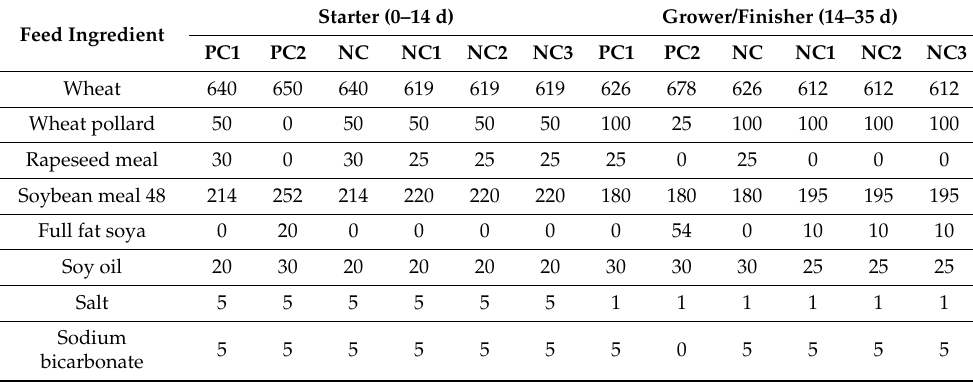
Table 1. Composition (g/kg) of the experimental treatment